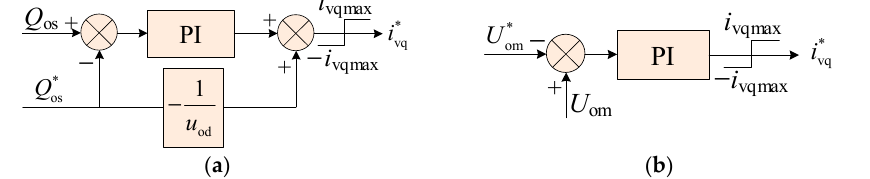
Figure 8. Reactive power control loop of outer loop controller on output side of M3C when ( a ) Q os* is given; ( b ) U om* is given.